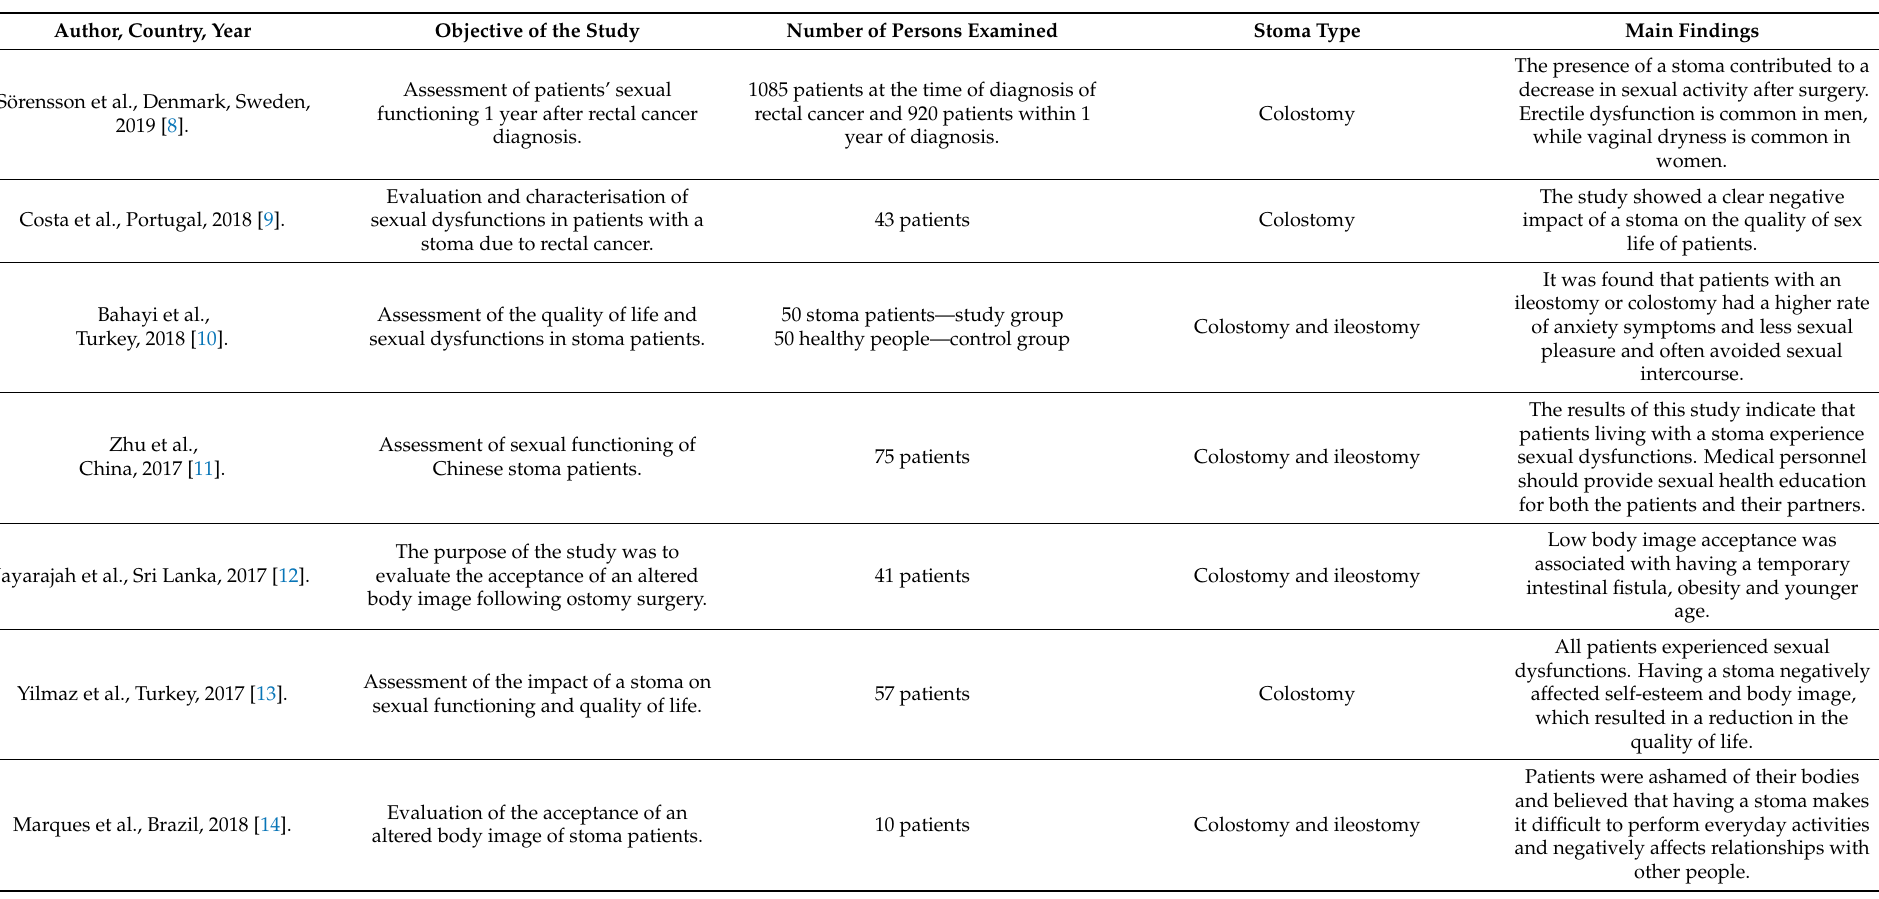
Table 1. Studies selected for inclusion in the literature